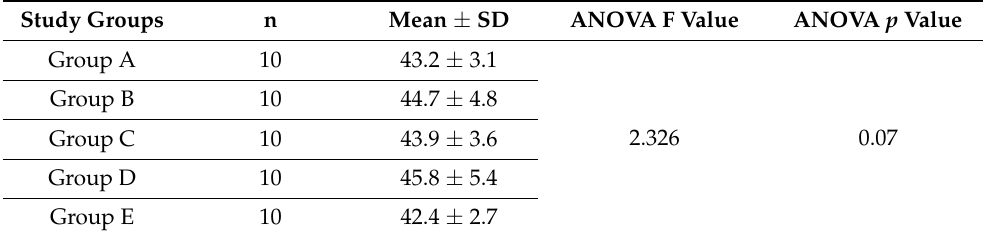
Table 3. Compressive strength (MPa) of tested specimens. Study Groups n Mean ± SD ANOVA F Value Group